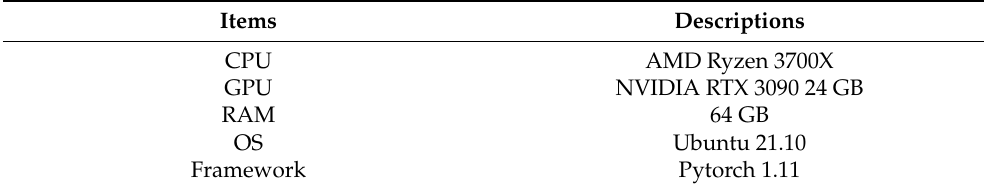
Table 1. Hardware and software